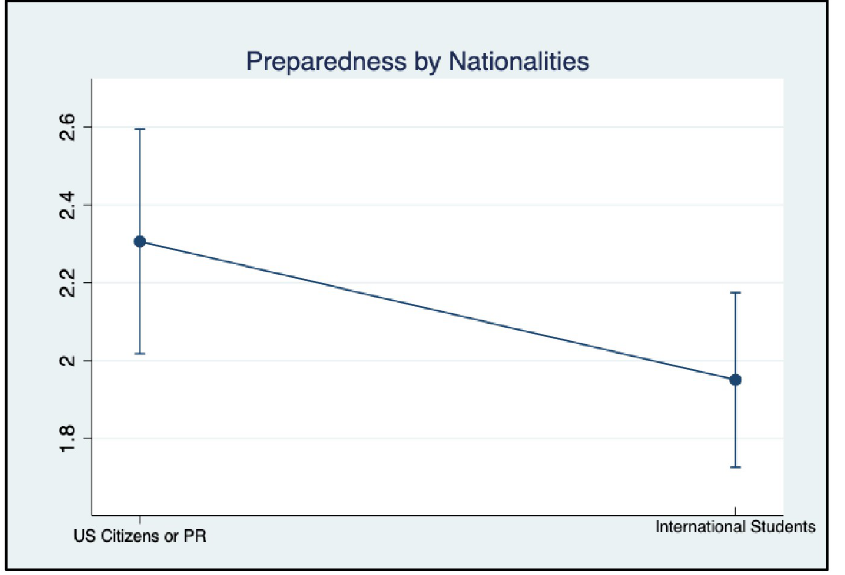
Fig 8. RDM preparedness by nationality.